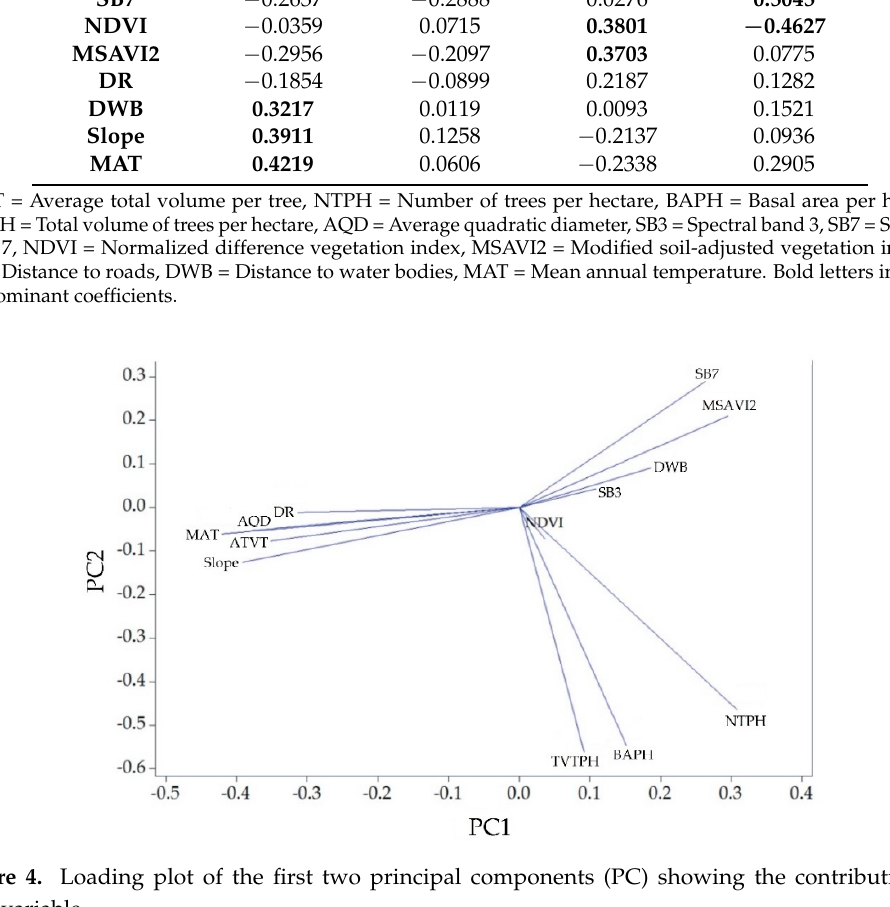
Table 3. Eigenvectors of the correlation matrix.